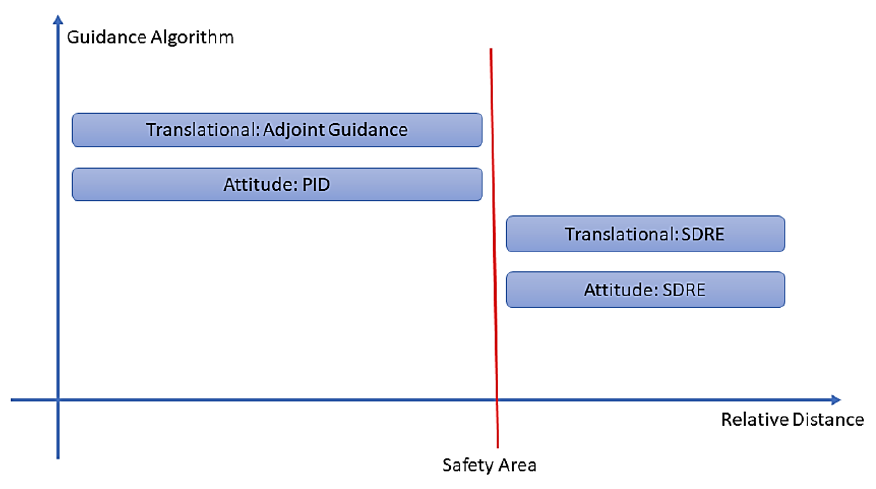
Figure 24. Schematic explanation of the guidance